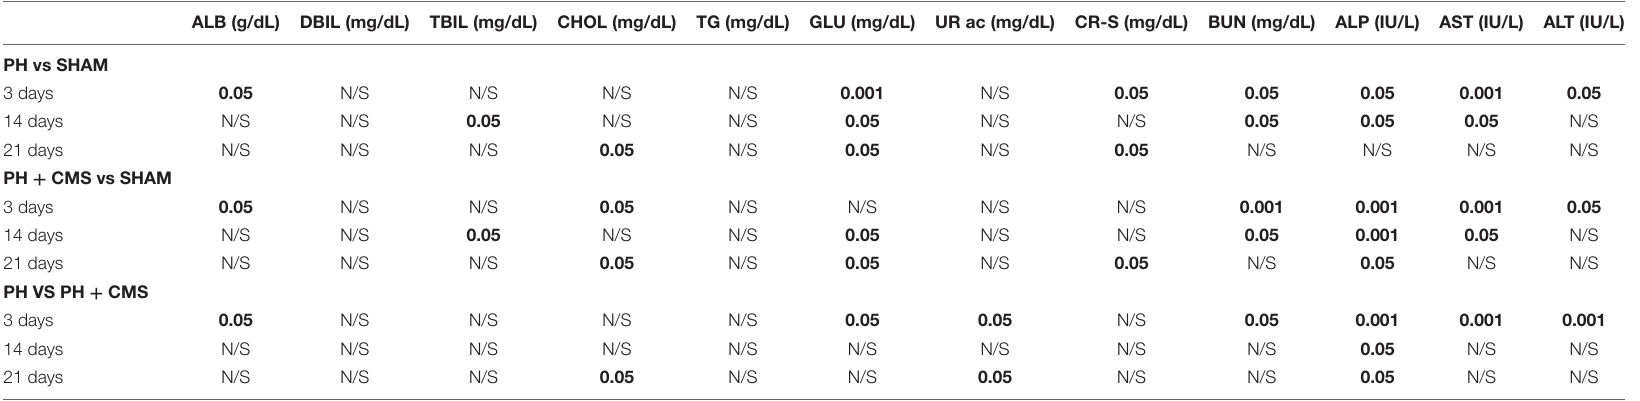
TABLE 3 | Intergroup comparison of the biochemical parameters.